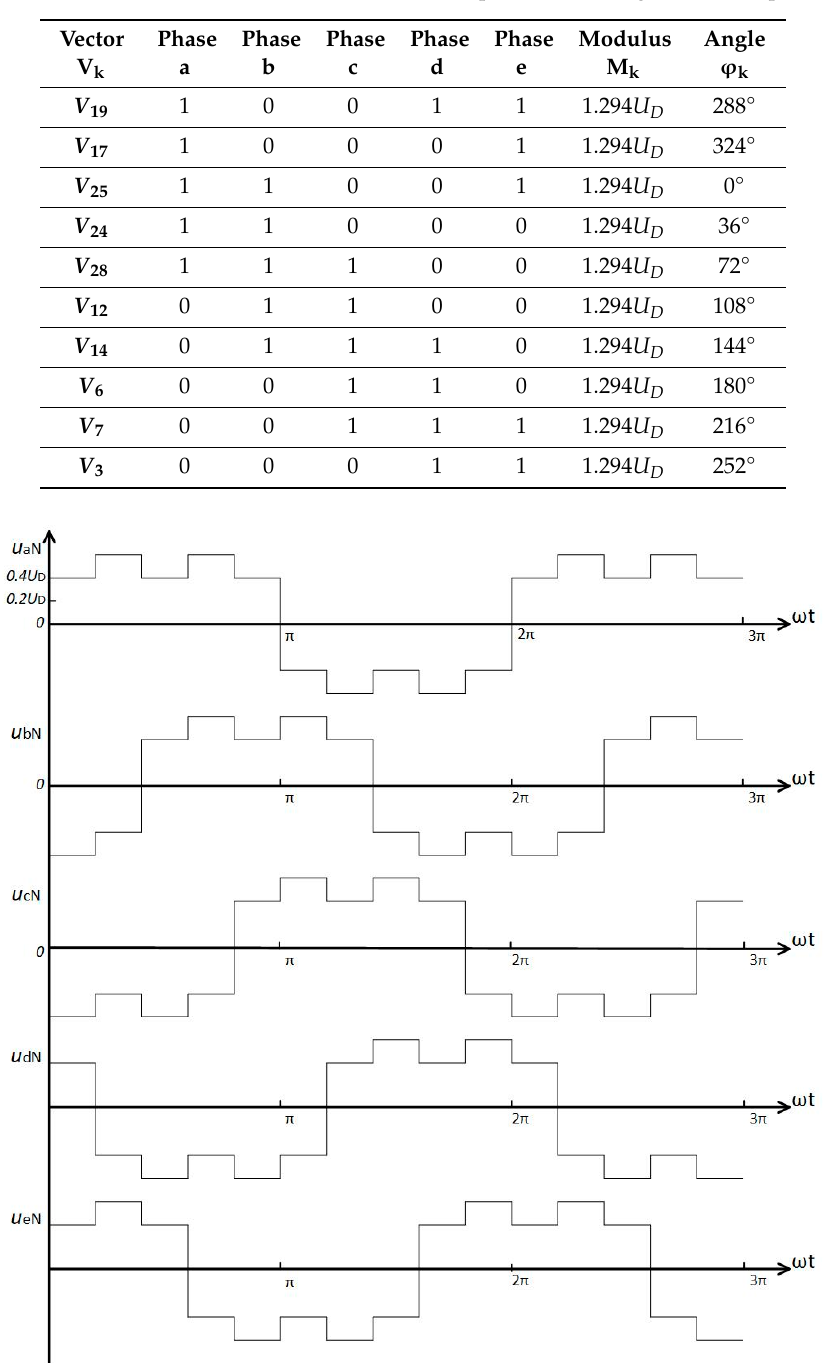
Figure 10. Phase voltage waveforms: the star connected load. Vector sequence: V 19 , V 17 , V 25 , V 24 , V 28 , V 12 , V 14 , V 6 , V 7 , V 3